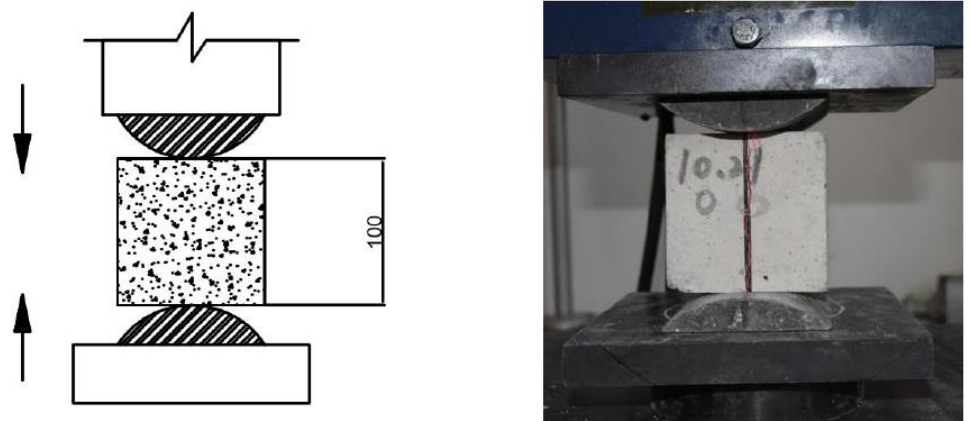
Figure 5. Loading diagram of specimen of tensile strength experiment.